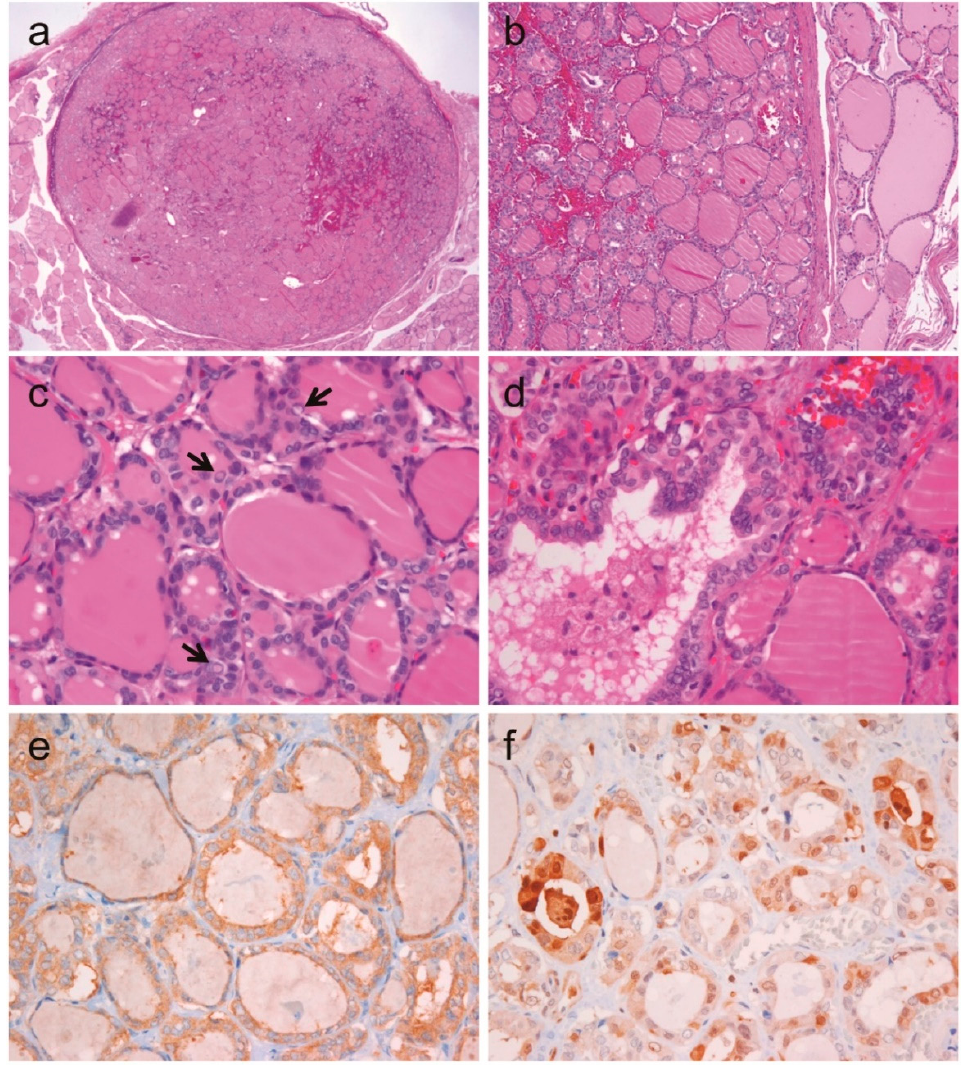
Figure 6. Noninvasive encapsulated classic papillary thyroid carcinoma with predominant follicular growth and BRAF V600E mutation. ( a ) Low magnification shows a well-circumscribed follicular tumor measuring 1.1 cm in greatest dimension ( × 12). ( b ) The tumor is clearly demarcated from normal thyroid tissue by a fibrous capsule ( × 100). ( c ) The nuclear features of tumor cells show nuclear enlargement, membrane irregularities, pseudoinclusions (indicated by arrows), and grooves ( × 400). ( d ) Follicles with abortive papillae are observed ( × 400). Immunohistochemistry shows diffuse positivity for BRAF VE1 ( e ) and focal positivity for cyclin D1b ( f